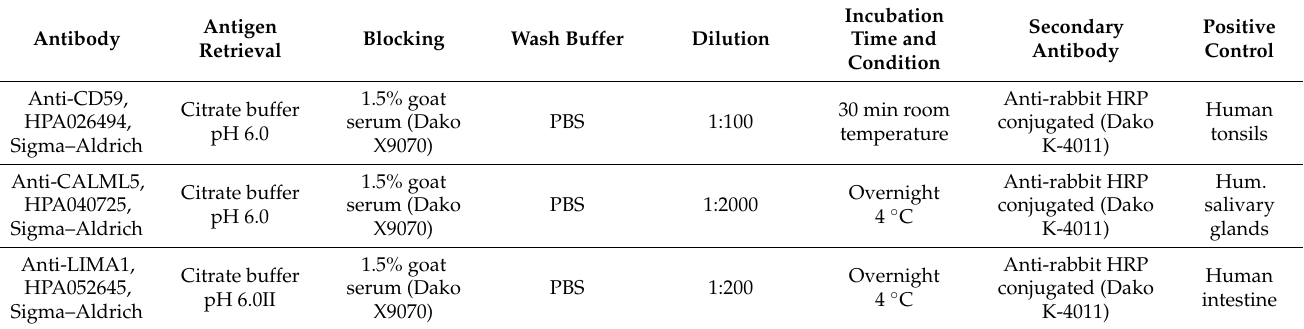
Table 3. List of antibodies and immunohistochemical